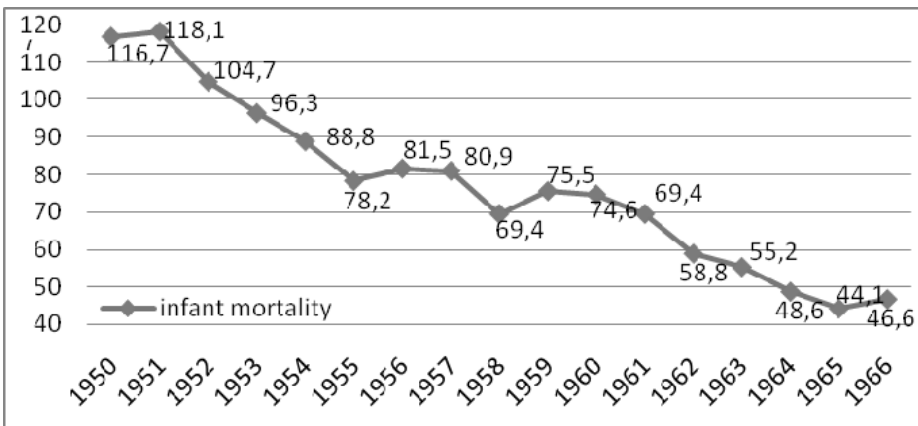
Figure 3. Infant mortality dynamics in Romania,